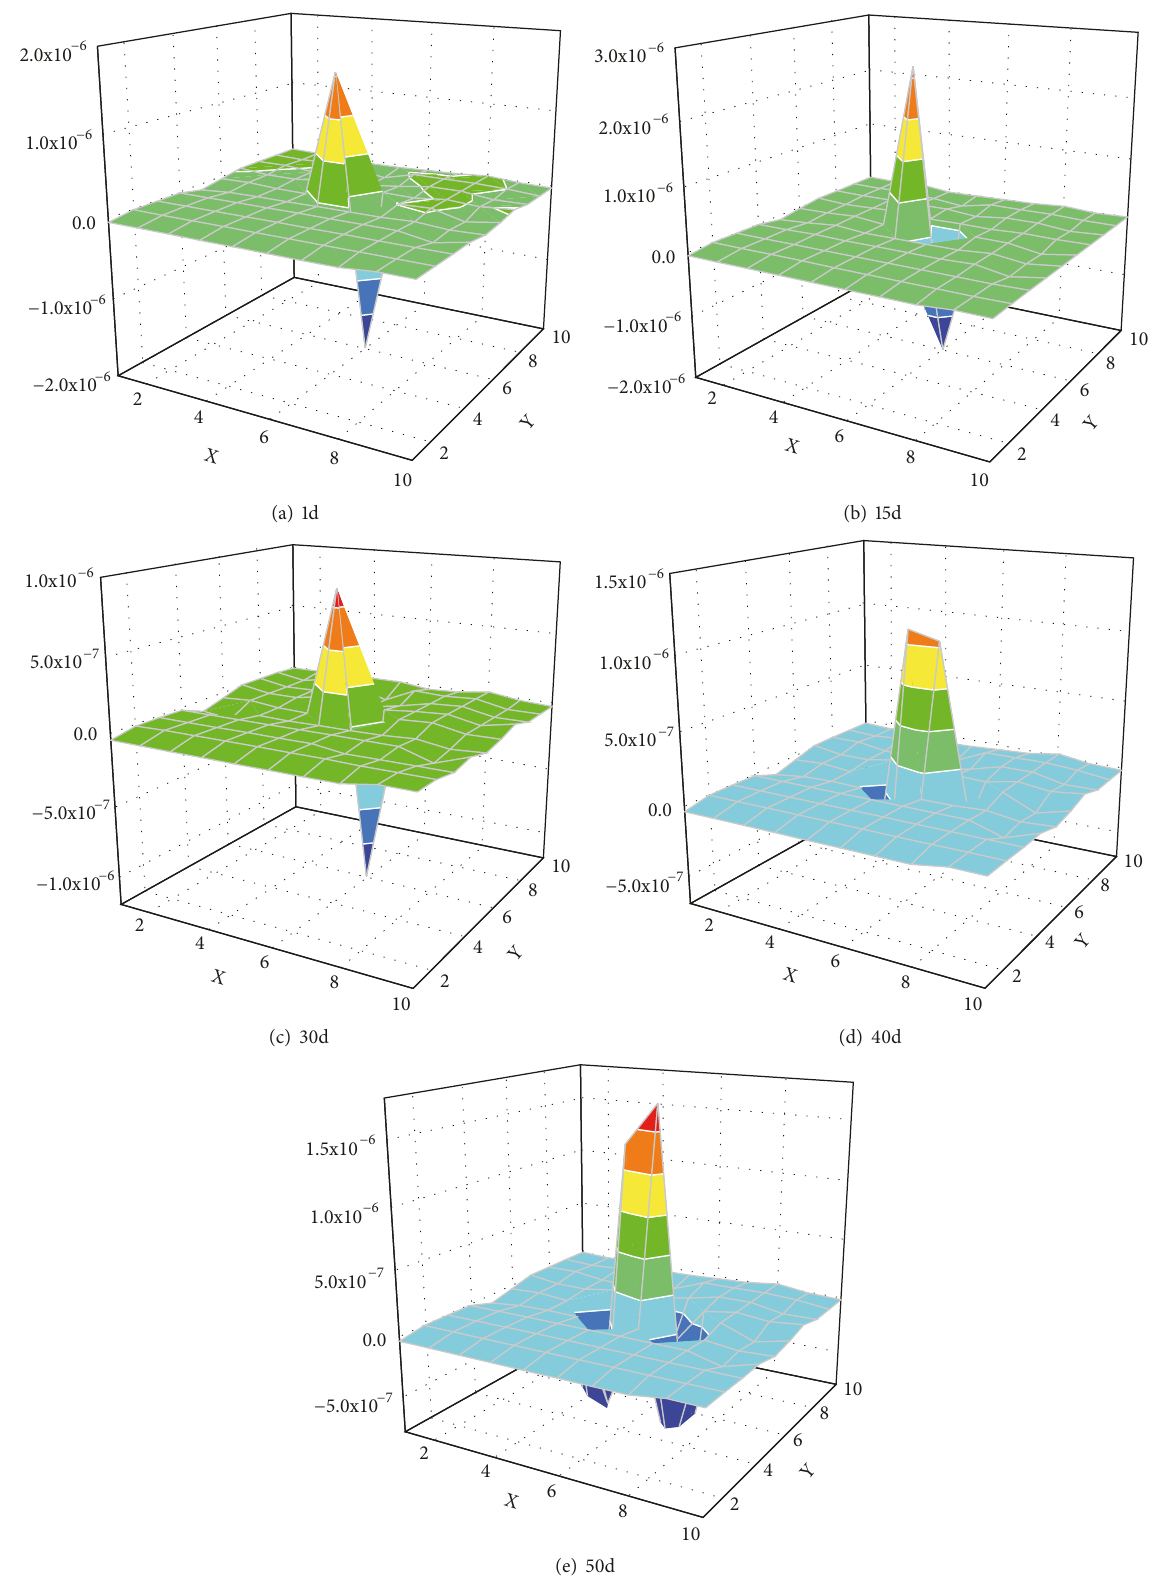
Figure 2: Current density distribution diagram of the scratch damage system immersed in distilled water for different